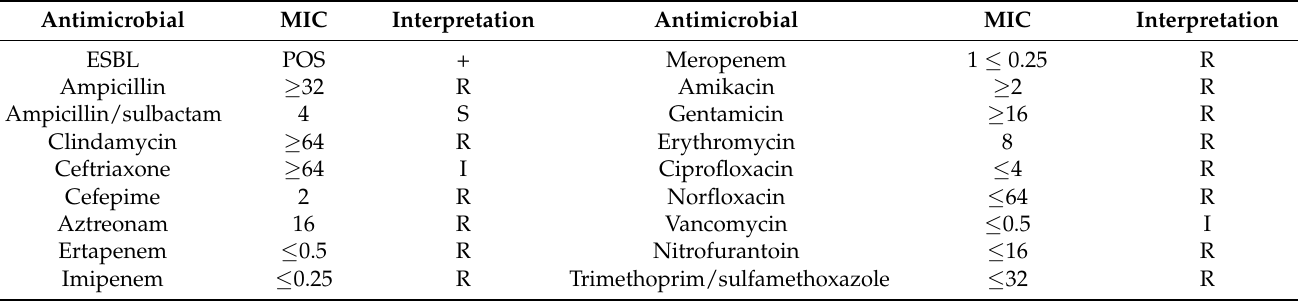
Table 4. VITEK 2 system for the identification and susceptibility testing of Salmonella typhi .